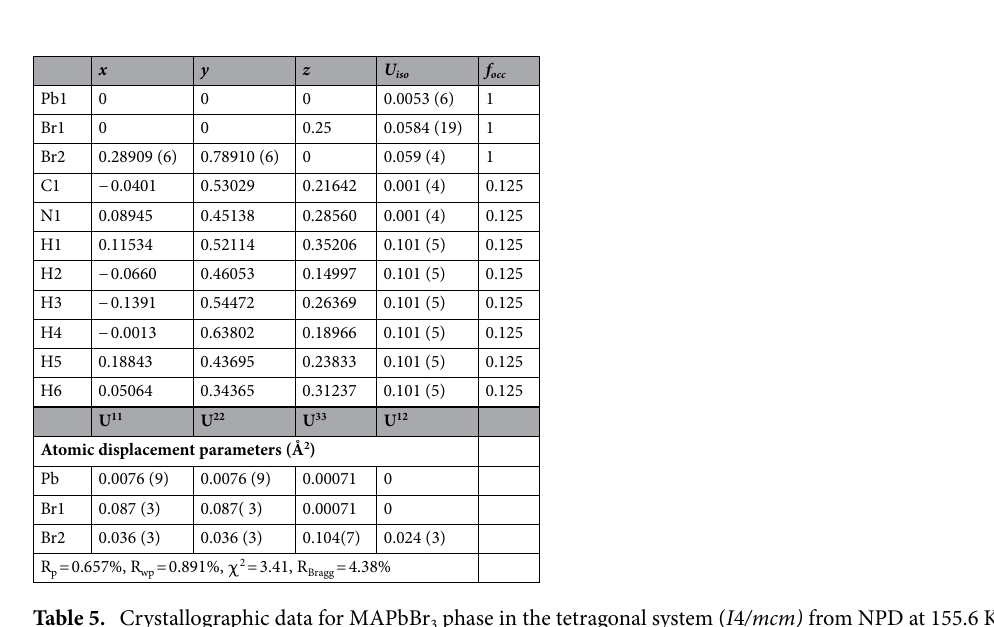
Figure 8. Two views of the tetragonal crystal structure of MAPbBr 3 , highlighting the H-bond interactions with adjacent Br atoms.